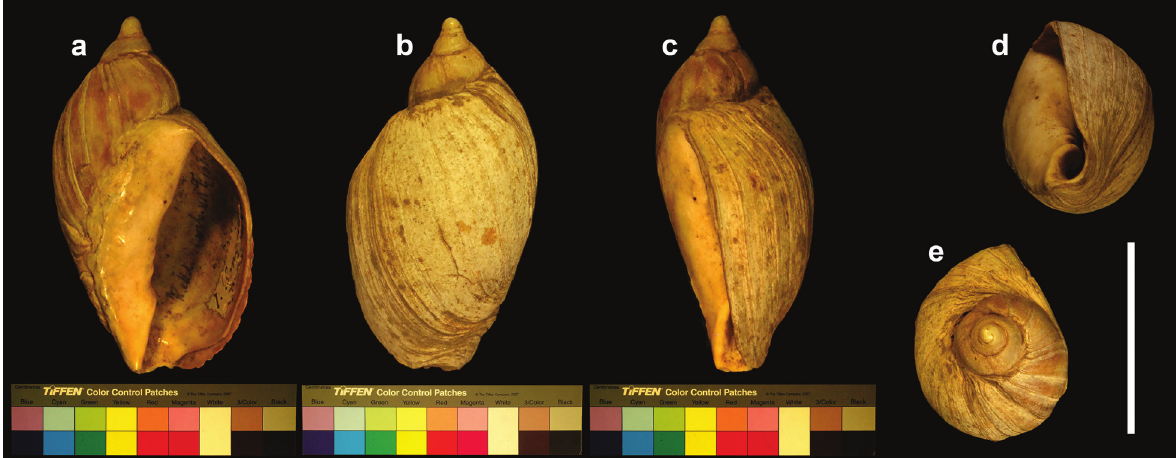
Figure 47. Voluta oviformis longiuscula , holotype figured by Lahille (1895: pl. VII, fig. 136) a Apertural view b Dorsal view c Lateral view d Umbilical view e Apical view. Scale bar: 5 cm.